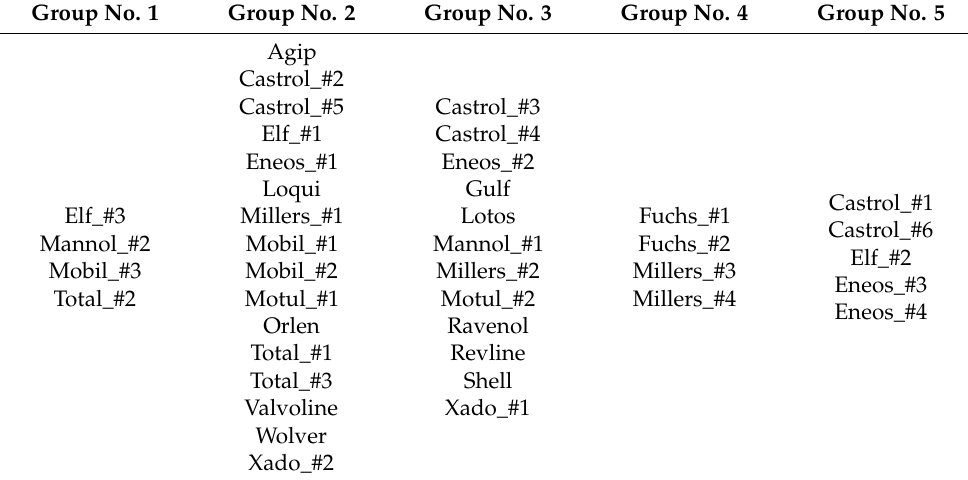
Table 7. Assignment of the oils into the different groupings according to similarity in susceptance values. Group No. 1 Group No. 2 Group No. 3 Group No. 4 Group No.